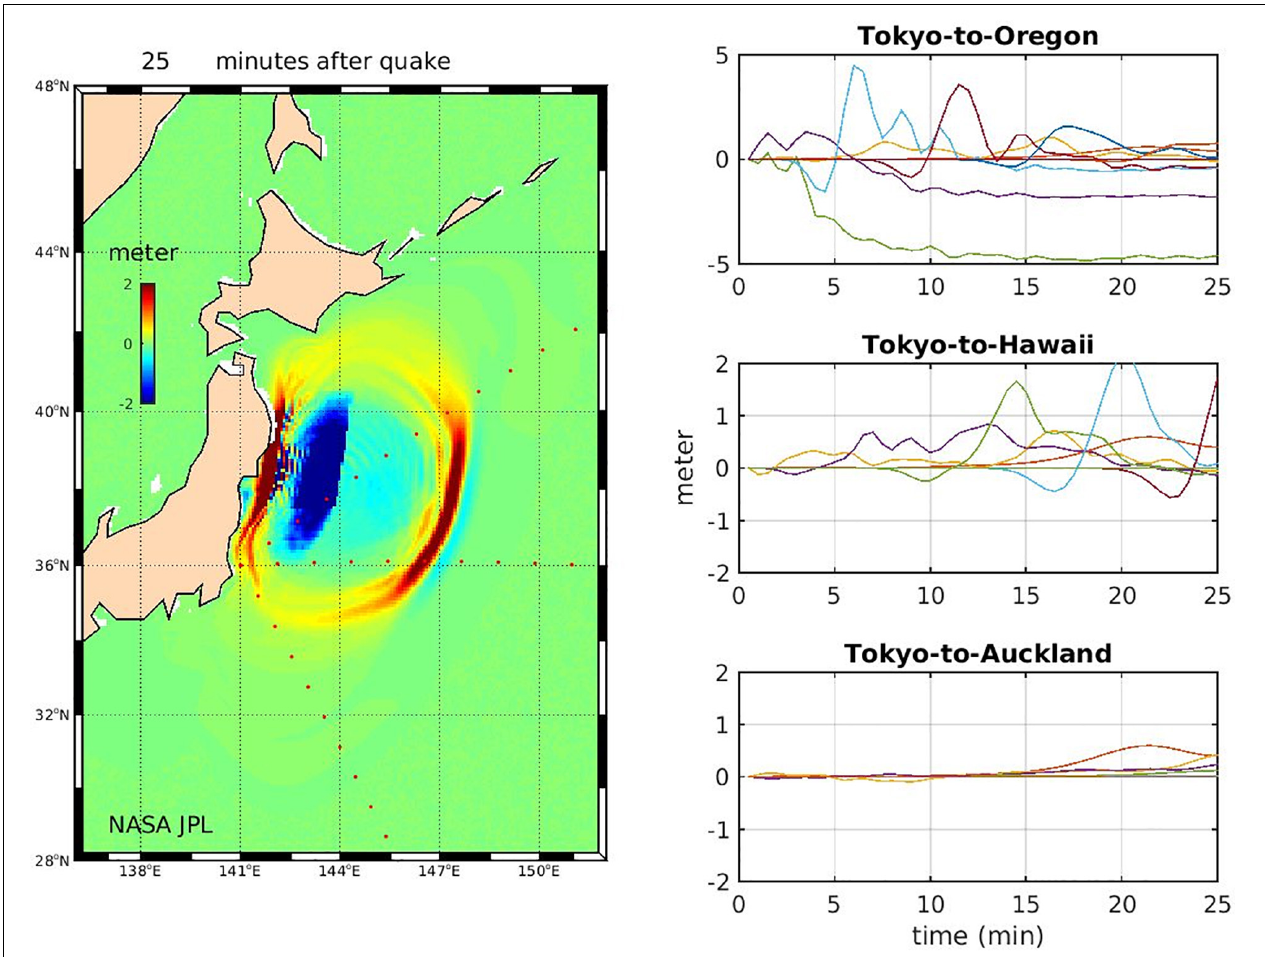
FIGURE 11 | Simulation of the 2011 Japanese tsunami with three hypothetical SMART cable routes: Tokyo to Oregon, Hawaii, and Auckland. Permission obtained for use of